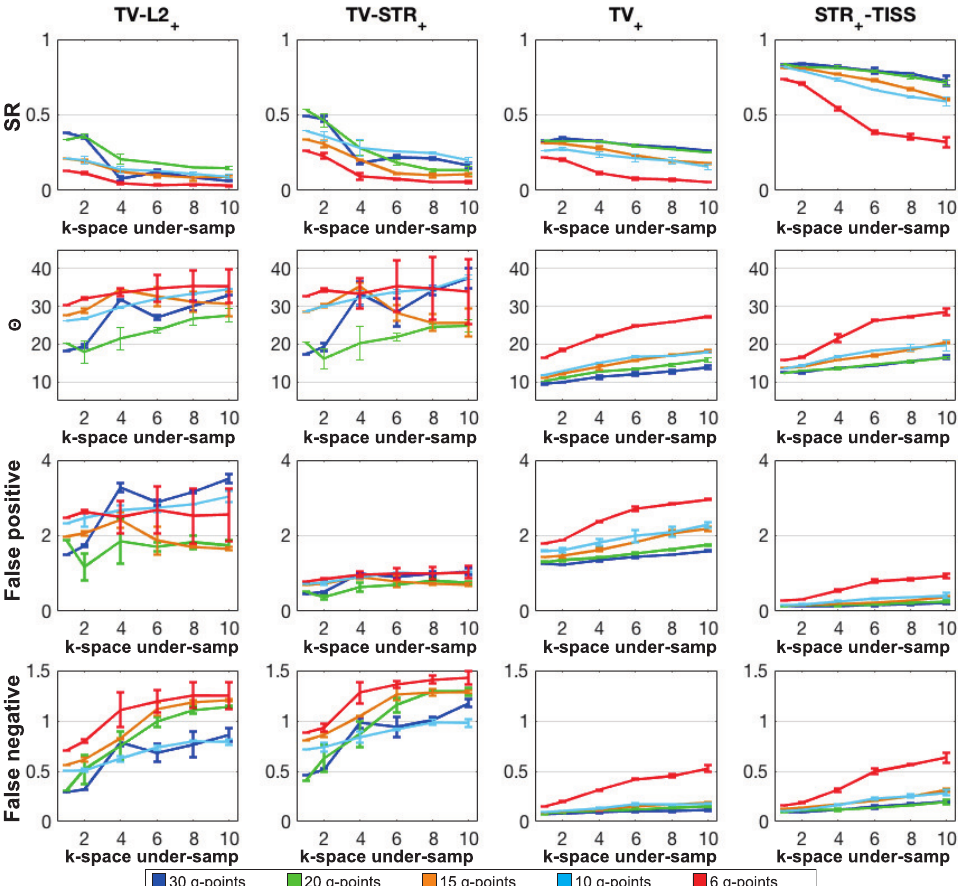
Figure 5. Quantitative evaluation of the fiber orientation estimated by using four different methods for the synthetic data from the ISMRM Tractography Challenge 2015. For the evaluation, the SR ( first row ), the mean angular error ( second row ), the number of false positives ( third row ) and false negatives ( fourth row ) are shown for each different method along each column. Reconstructions were performed considering different number of q-points (i.e., M ∈ { 6,10,15,20,30 } ), shown using different colors and for different k-space under-sampling factors (i.e., N / K ∈ { 1, . . . ,10 }